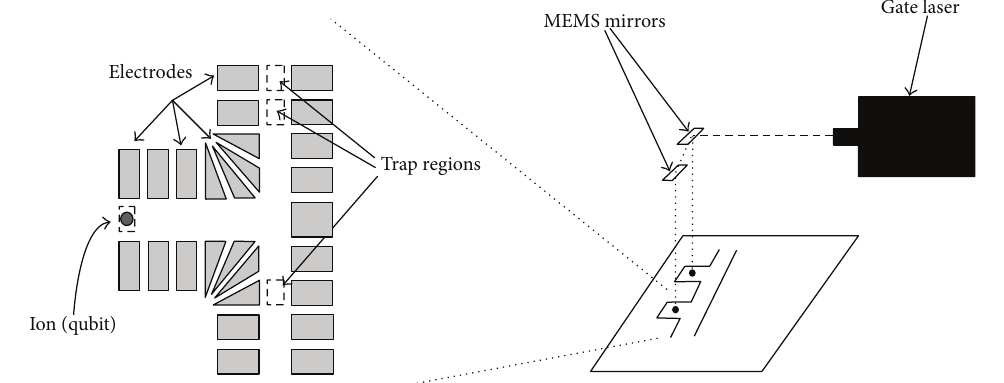
Figure 2: Simplified ion-trap technology view [5].